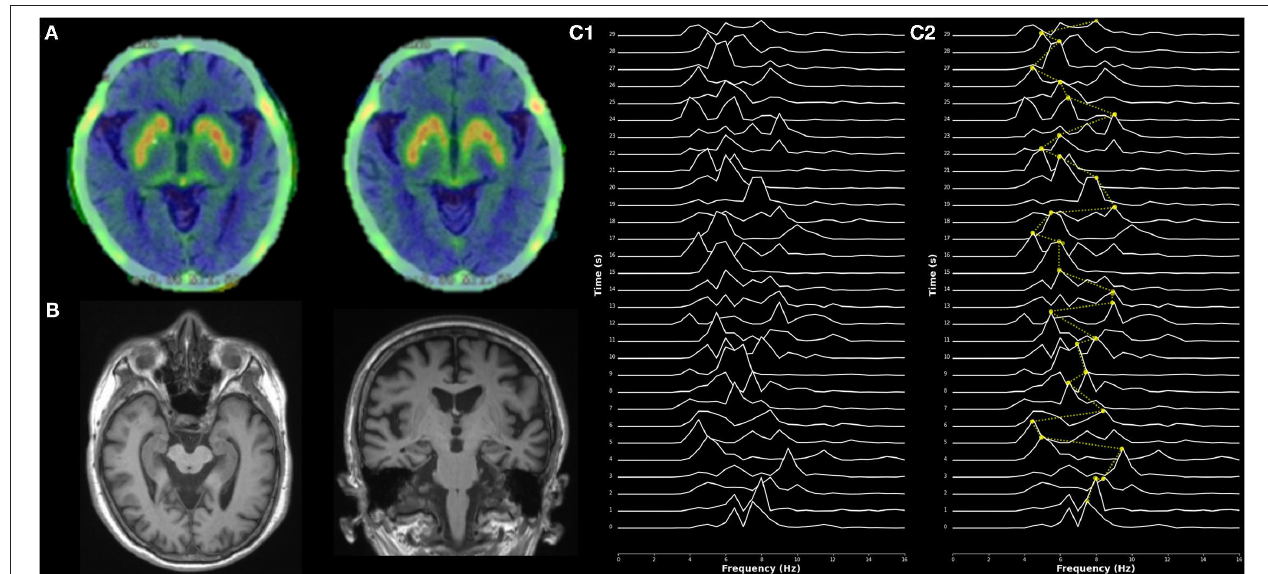
FIGURE 2 | Imaging and electrophysiological findings. (A) 18 F-dihydroxyphenylalanine 18 F-DOPA PET showed reduced dopamine uptake in the nigrostriatal regions. (B) Axial (left) and coronal (right) MRI planes of hippocampal structures in T1 sequence, showing relative sparing of hippocampi. (C) Electroencephalogram (EEG)—Compressed spectral arrays (CSA) showing stacked plots of the power spectral density for each 1-s epoch. Frequencies lower than theta were filtered as could be affected by artifacts. (C1) CSA from derivation O1 (left occipital) during the eyes-closed condition. (C2) Interpretation of CSA from derivation O1 (left occipital). Yellow dots illustrate the dominant frequency (frequency with a maximum power peak) in each 1-s epoch. The dotted yellow line depicts dominant frequency variability across epochs. Dominant frequency in each epoch variates from the alpha band (at 9Hz) to the pre-alpha/fast-theta band (at 6–7Hz). Dominant frequency variability of 3Hz is